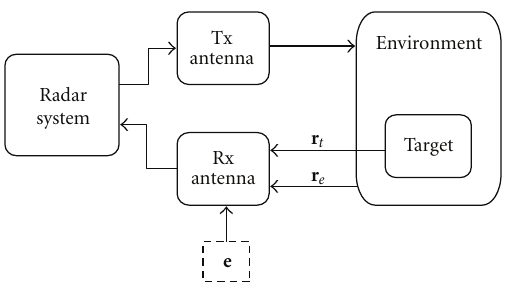
Figure 4: Signal system model, where the received signal r is con- structed of three additive parts: the clutter r e , the target signal r t , and the noise e